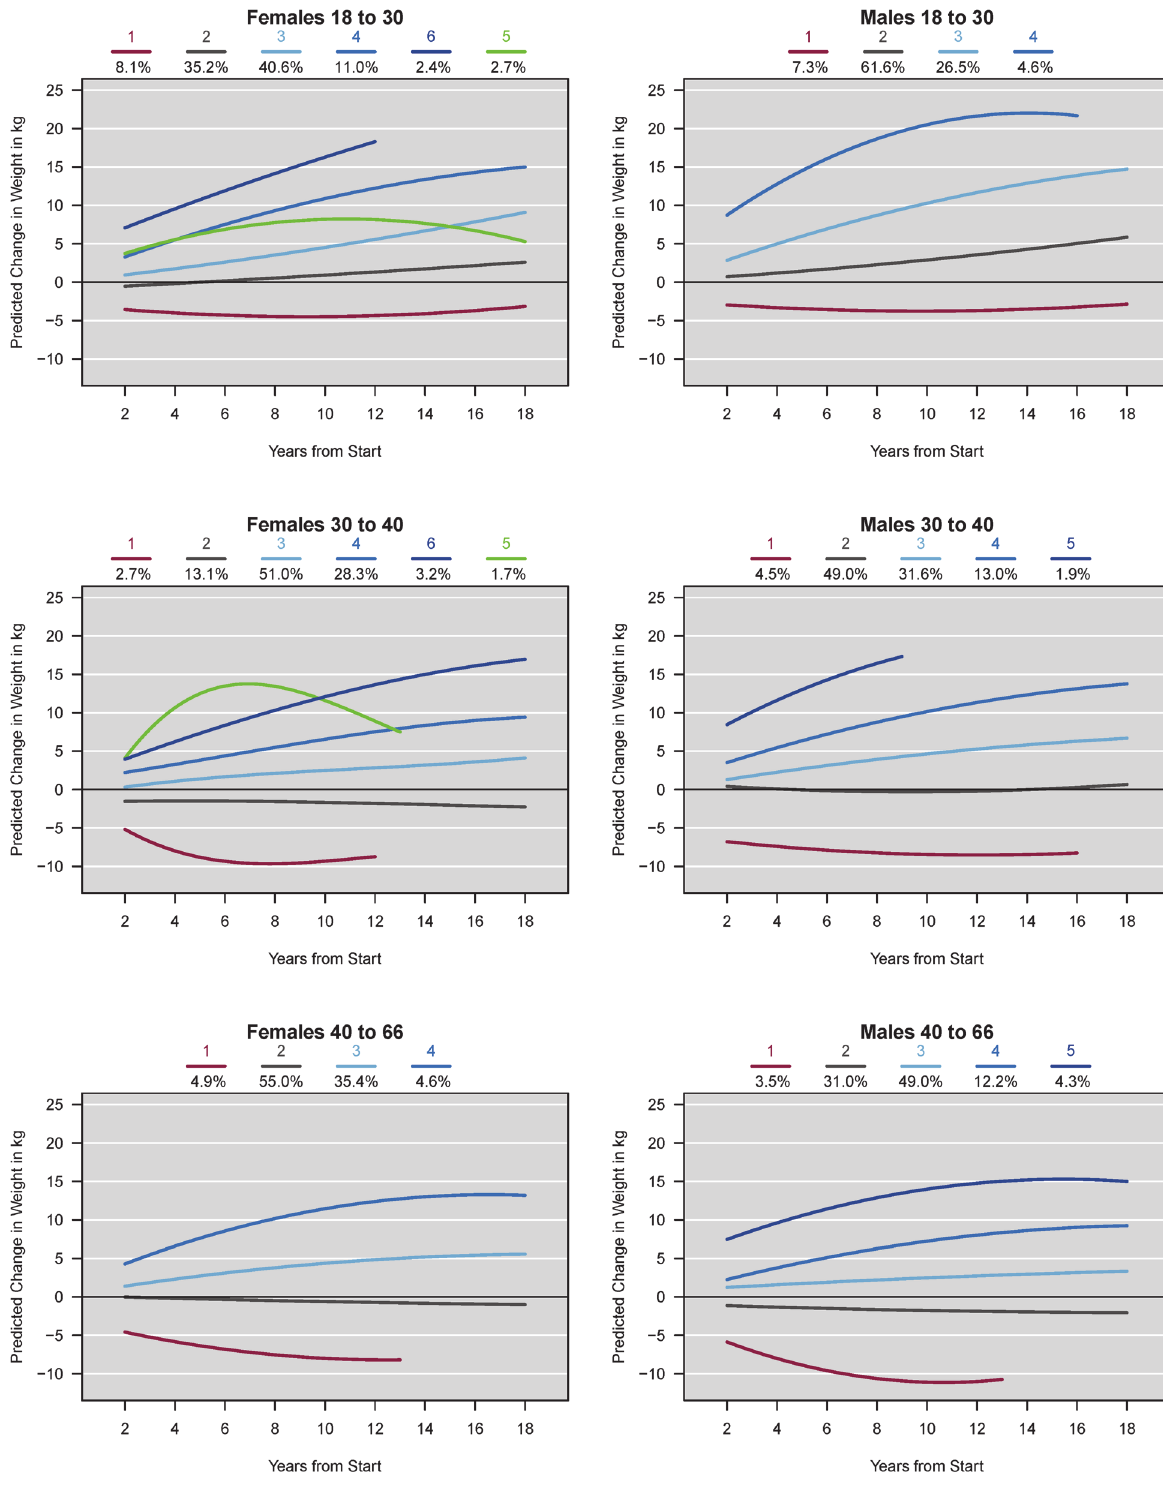
Fig 1. Derived weight trajectories by sex, across three age strata, China Health and Nutrition Survey. Derived weight trajectories are for the 18 year study period. Each age-sex stratum includes a different set of trajectory classes specific to the within-strata weight trajectories. Separate colors indicate each weight trajectory class, with percent of sample in each class for each sex-age strata shown above each figure.